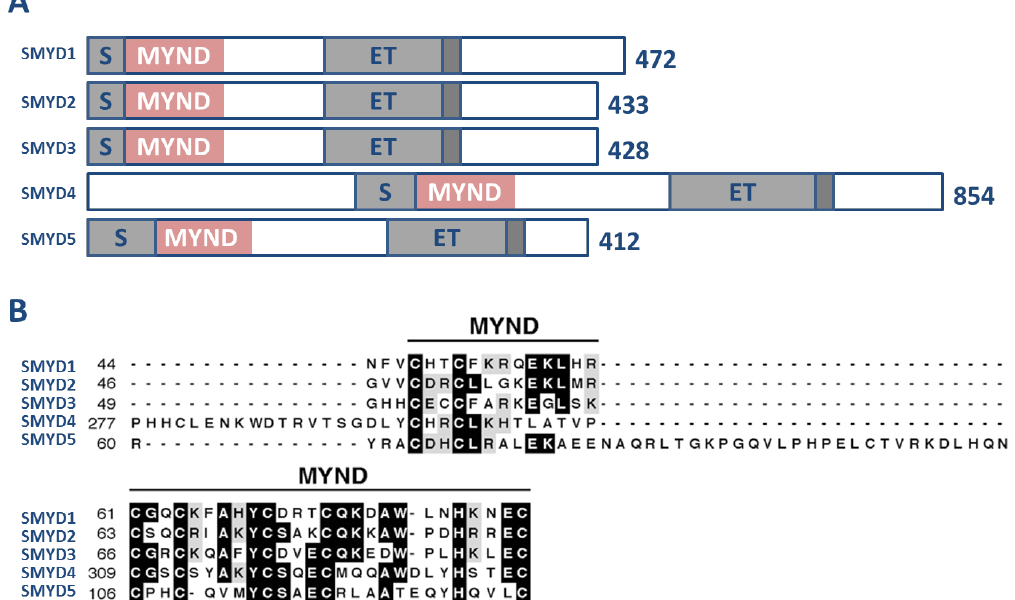
Figure 1. ( A ) Schematic representation of the five mammalian SMYD proteins. The split SET domain is shown in light gray; the MYND domain is shown in pink; the cysteine-rich post-SET domain is shown in dark gray; ( B ) ClustalW and BOXSHADE programs were used for alignment and shading of the MYND domains associated with each of the five SMYD